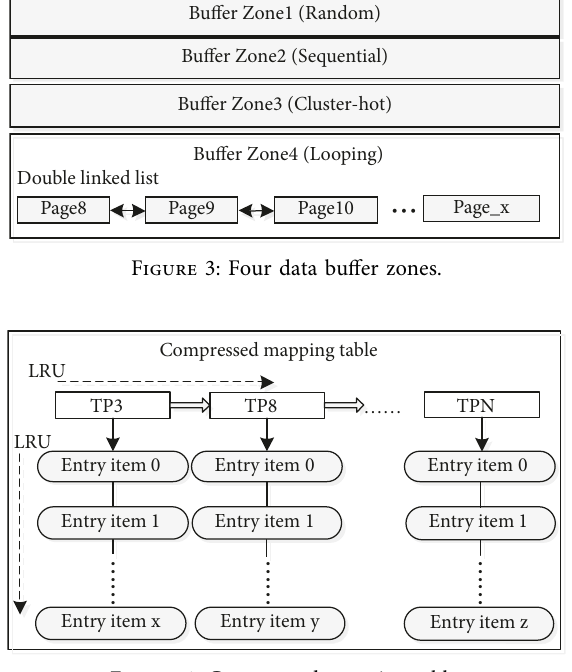
Figure 4: Compressed mapping